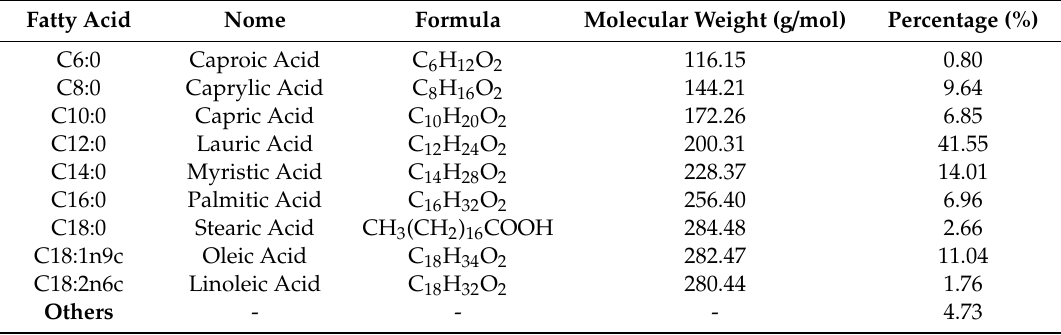
Table 2. Percentages of free fatty acids in the chemical composition of residual oil from babassu.